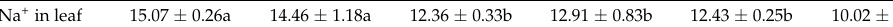
Table 1. Leaf sodium content under different irrigation modes.